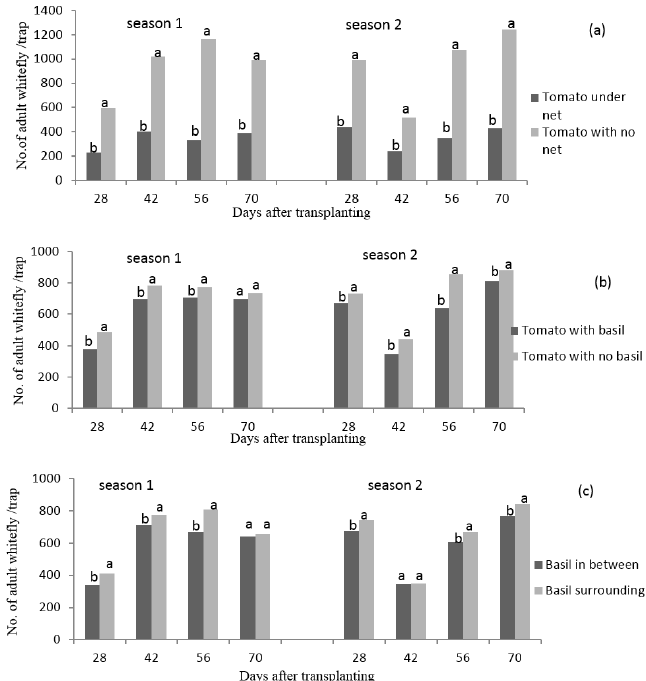
Figure 4. Effects of agronet cover ( a ); companion planting ( b ) and planting design ( c ) on number of adult B. tabaci on sticky traps (no./trap)during tomato production in season 1(December 2013–April